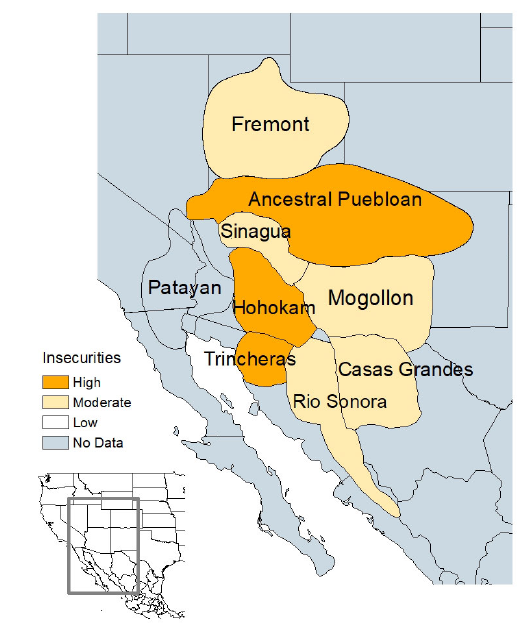
Fig. 4 . Health insecurity prior to depopulation (indicator: increasing settlement aggregation and skeletal indicators of disease).